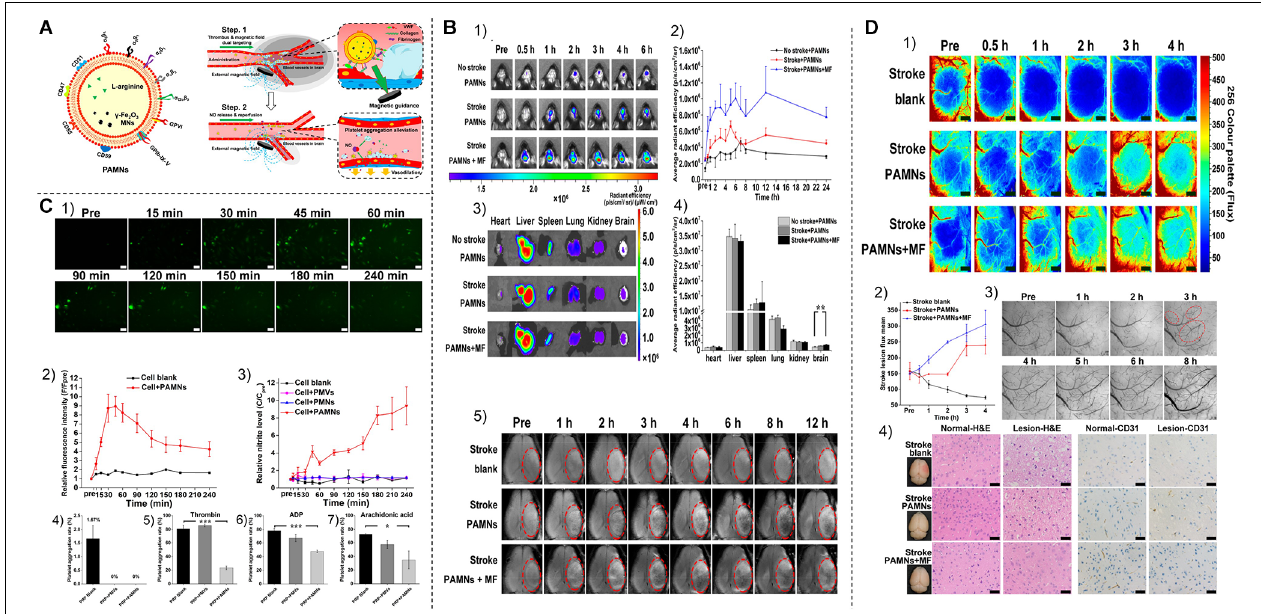
FIGURE 5 | (A) Schematic structure and in vivo targeting pattern of PAMN. (B) NIR fluorescence imaging of PAMN in vivo in mice with ischemic stroke. (1) NIR fluorescence images of different groups of mice before and after injection of DIR-labeled PAMN. (2) Quantification of the mean intensity of DIR fluorescence signals in the brains of different groups of mice before and after the injection of DIR-labeled PAMN. (3) In vitro NIR fluorescence imaging was performed on the major organs resected 6 h after PAMN injection. (4) Quantify the intensity of DIR fluorescence signal in different groups of mice organs. (5) In vivo T2 MRI was performed before and after saline and PAMN injection. (C) In vitro characterization of nitric oxide production and biological functions. (1) Micrographs of NO production over time in DAF-FM DA-stained bEnd.3 cells. (2) Relative fluorescence intensity of NO production in bEnd.3 cells. (3) Relative nitrite levels in the culture supernatant were measured by Griess reaction. (4) PLT aggregation experiments after the addition of PMVs and PAMN to citrate-stabilized PRP. (5–7) Detection of thrombin, adenosine diphosphate, and AA-induced platelet aggregation rates after addition of PMV and PAMN. (D) Stroke reperfusion and immunohistochemical analysis. (1) Color laser scatter images show reperfusion of blood flow within the ischemic lesion within 4 h after thrombosis, which is comparable to the accepted treatment time window (4.5 h). (2) Quantitative analysis of blood flow within the ischemic lesion. (3) After PAMNS injection, bright-field images of the stroke vascular network were obtained at 560 nm with a multimodal optical imaging system, followed by the application of MF. (4) Normal brain tissue (left) and ischemic injury tissue (right) were stained for H&E and CD31. * P < 0.05; ** P < 0.01; *** P < 0.001. Reprinted (adapted) with permission from Li et al. (2020). Copyright 2020 American Chemical